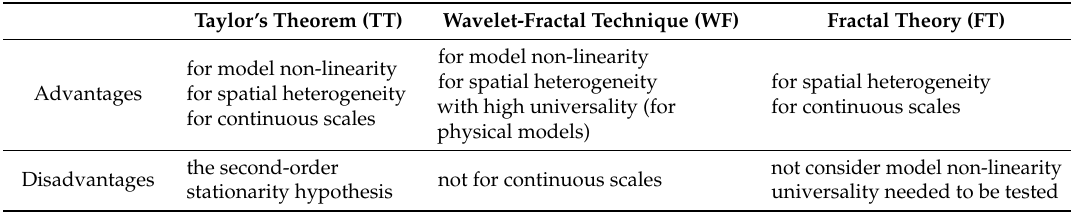
Table 4. Summary of characteristics of the three